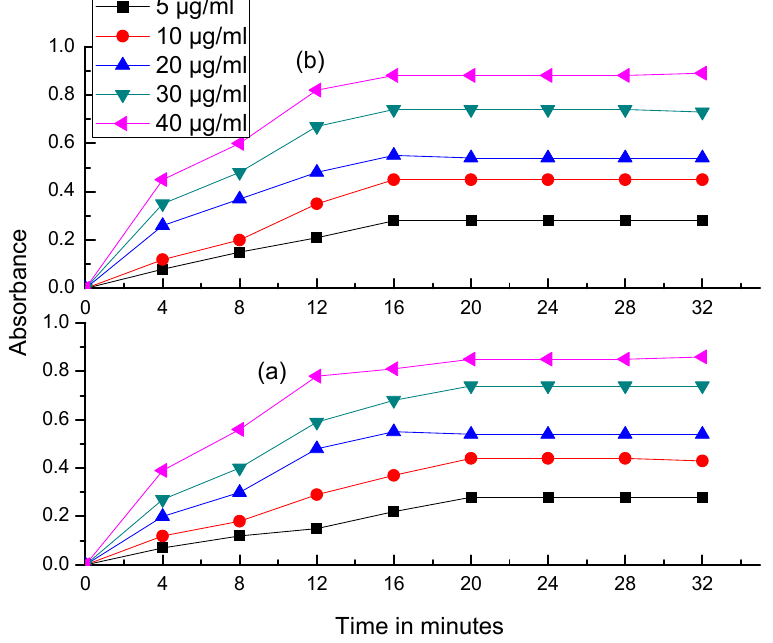
Figure 7. Absorbance vs. time plots: ( a ) VEN and ( b ) [NDV + Cyclic VEN].